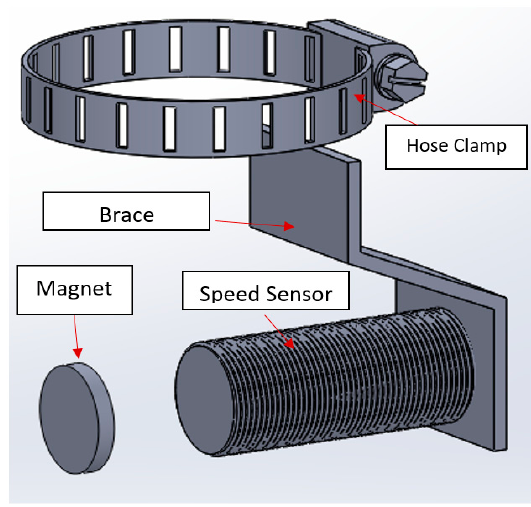
Figure 3. Speed sensor design.